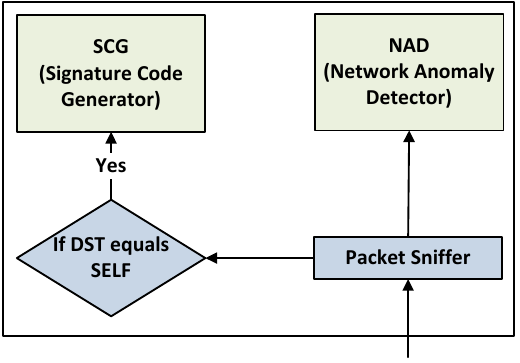
Figure 3. Internal architecture of intrusion detection component on a sensor